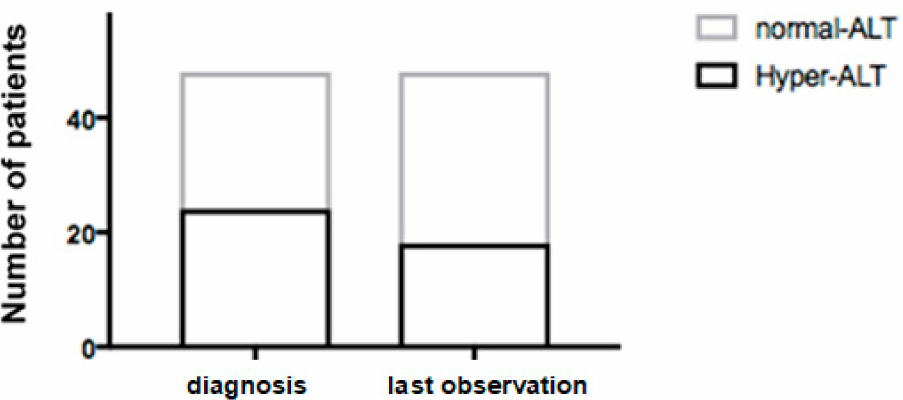
Figure 1. HFI patients ( n = 48) with and without hypertransaminasemia at diagnosis and at the end of follow-up. ALT, alanine aminotransferase.